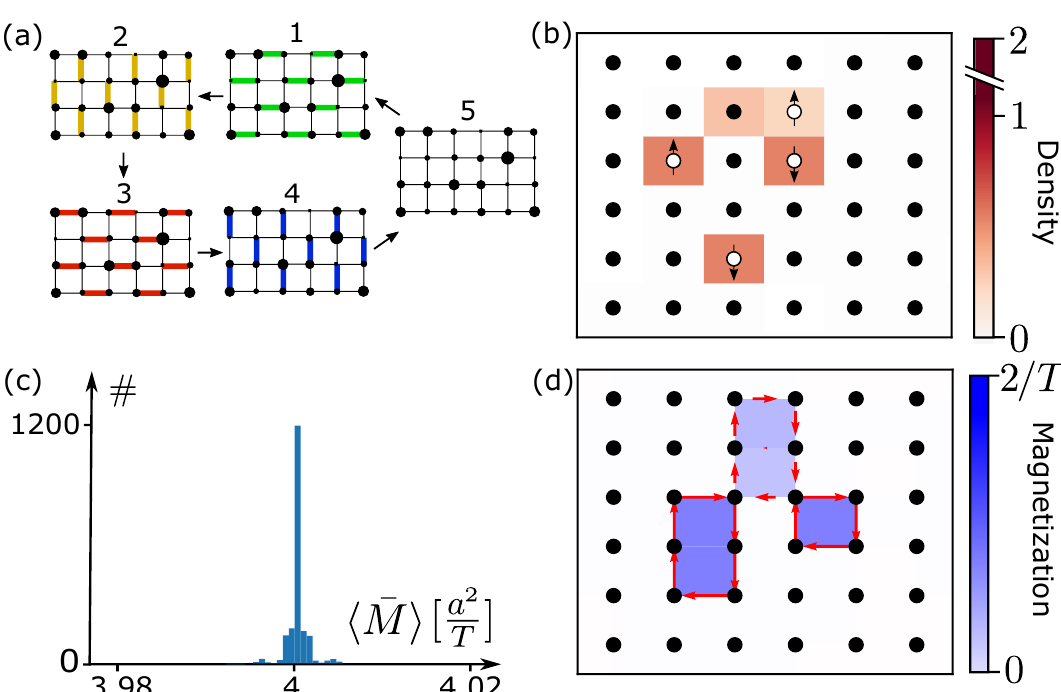
Figure 3: Simulations of model studied in Sec. 4 in the case of weak interactions, where it realizes the AFI phase (see main text for details). (a) Schematic depic- tion of the driving protocol. (b) Final particle density after 5000 driving periods for initialization in a random on-site configuration of particles (initial configuration of particles marked by white). (c) Histogram of magnetic moments of 1972 randomly chosen initial states that are evolved for 5000 periods (see main text for details). A single outlier at value 3.89 is not shown here. (d) Time-averaged bond-current (red) and magnetization density in the system (blue) for the realization depicted in panel